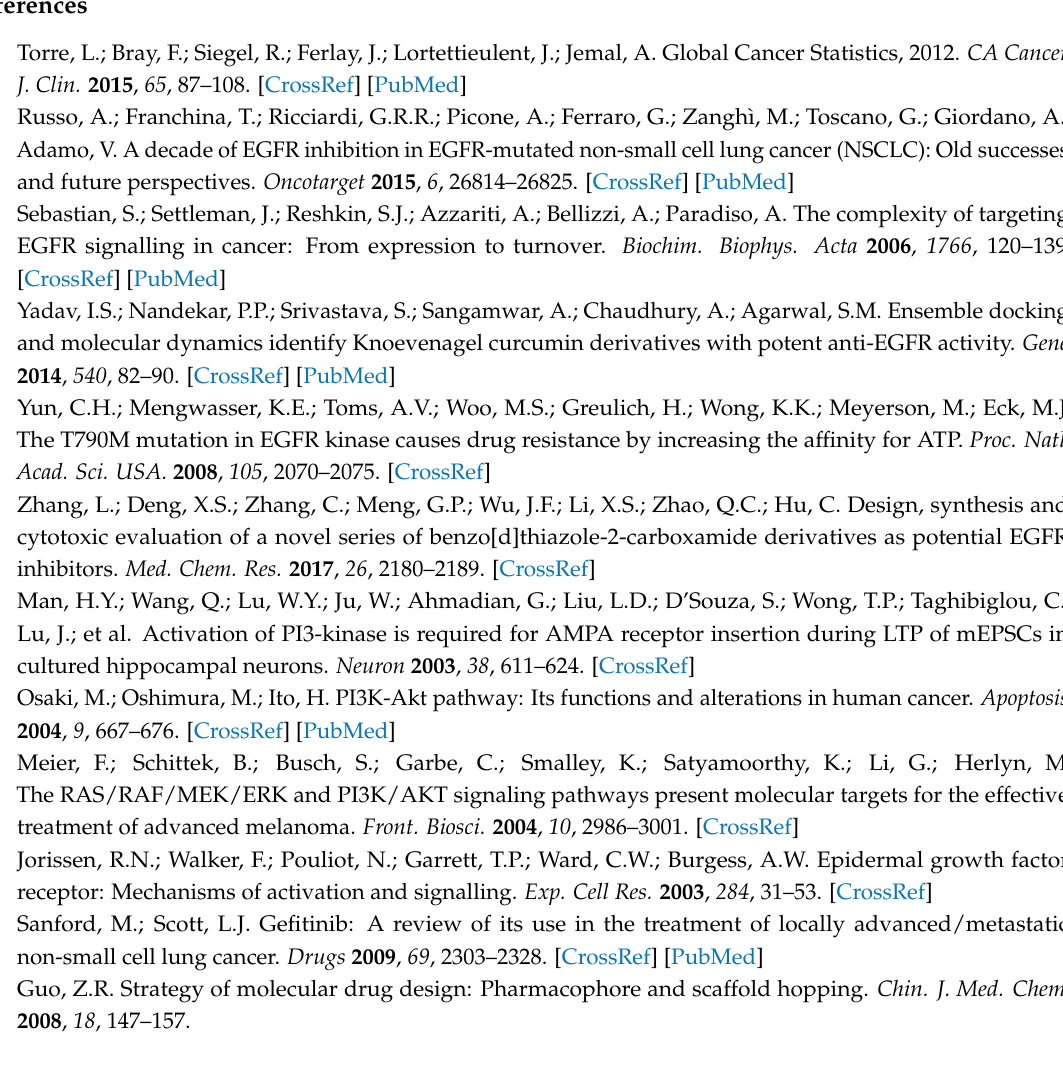
Figure S1-S90: IR, 1 H-NMR, 13 C-NMR, ESI-MS, and HRMS of the target compounds D01 - D18 ,